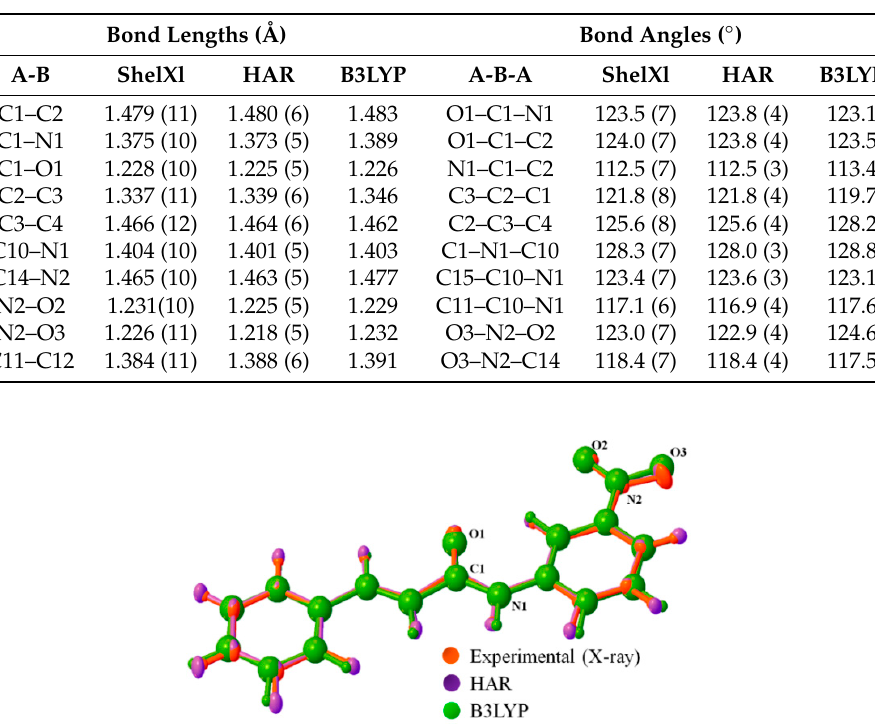
Figure 6. F obs − F calc difference electron density plot of the structure refined using the standard anisotropic spherical atom approach (Shelxl2018). The F obs − F calc map cutoff values are at 0.14 electrons per cubic Ångström. Difference densities are located mainly on bond critical points (“bonding electrons”). Table 3. Selected bond lengths (Å) and bond angles (°) for Compound 1 .